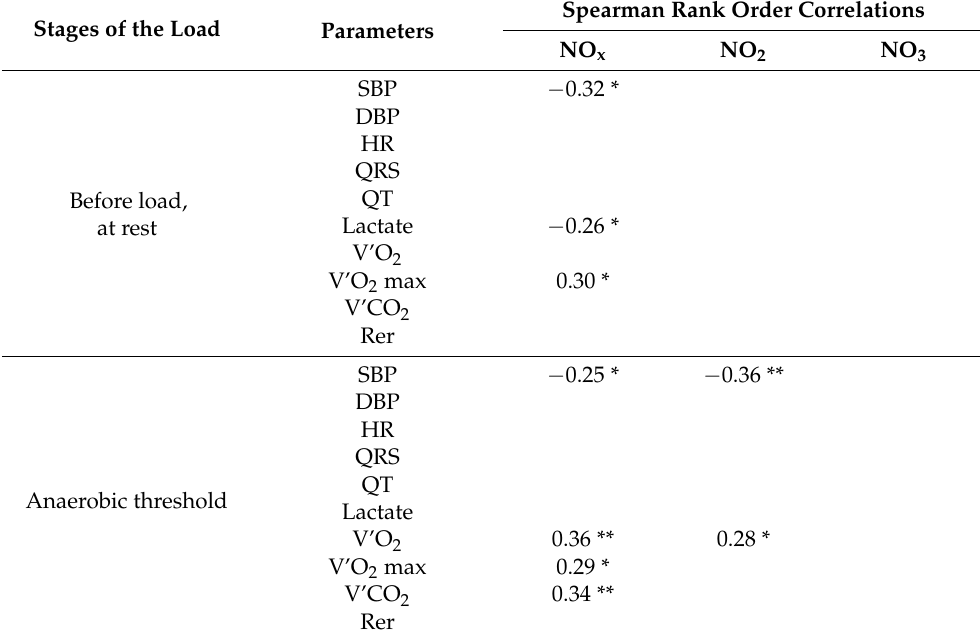
Table 4. Correlations between biochemical and cardiorespiratory parameters at different stages of cross-country skiers in Group